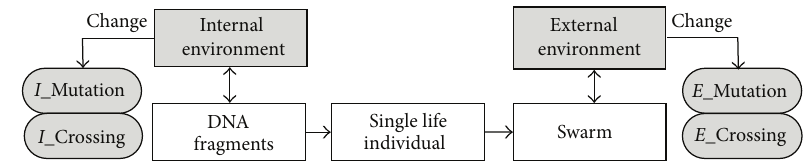
Figure 2: Individual evolution based on external and internal environment